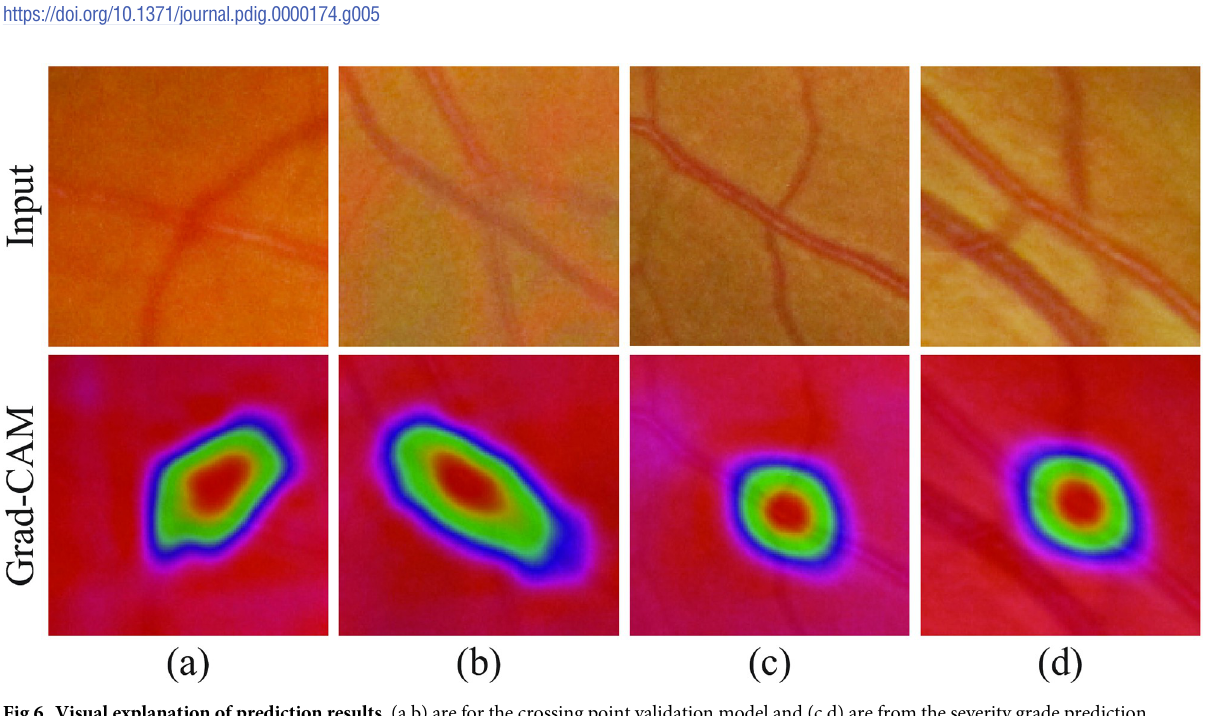
Fig 6. Visual explanation of prediction results. (a,b) are for the crossing point validation model and (c,d) are from the severity grade prediction model. The first row is the raw input images and the second row is the class-discriminative regions.